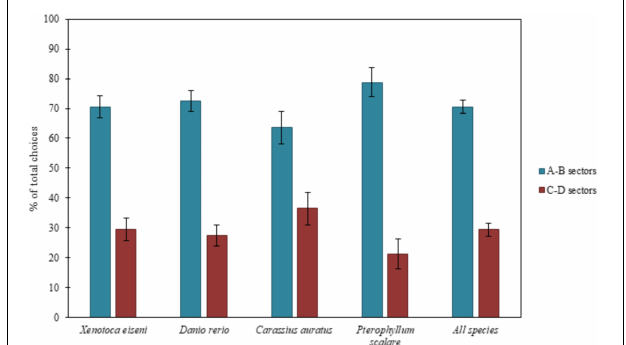
FIGURE 2 | Results of the total choices. The bars graph shows the percentages of choices (group means ± SEM are shown) for the two correct compartments (A-B) versus the two incorrect compartments (C-D) of the experimental apparatus, considering all species both separately ( X. eiseni , D. rerio , C. auratus , P. scalare ) and together. Four species of fish indistinctly were able to solve the detour task, choosing predominantly both the two correct compartments (A-B) close to the goal rather than the incorrect ones (C-D) far from the goal: moving away momentarily from the goal, they seem to be able to keep in mind the object to